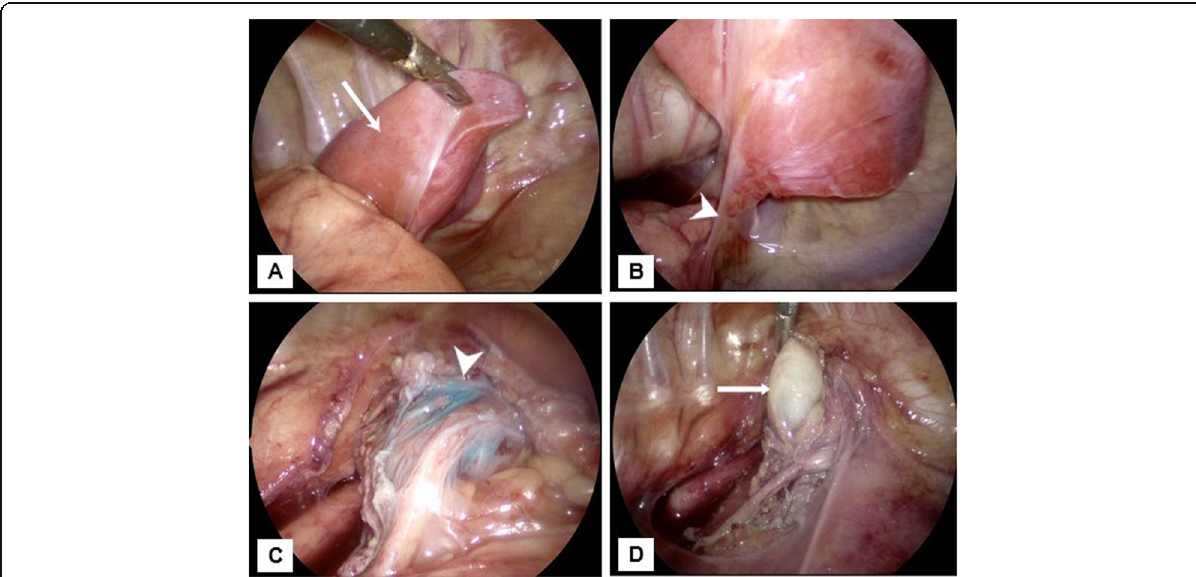
Fig. 4 Intraoperative images during thoracoscopy with visualization of an extralobar pulmonary sequestration (arrow) in the right upper thorax ( a ) that is invested in its own pleura. The sequestration appears to be connected to the mediastinum via a stalk (arrowheads in b and c ) that